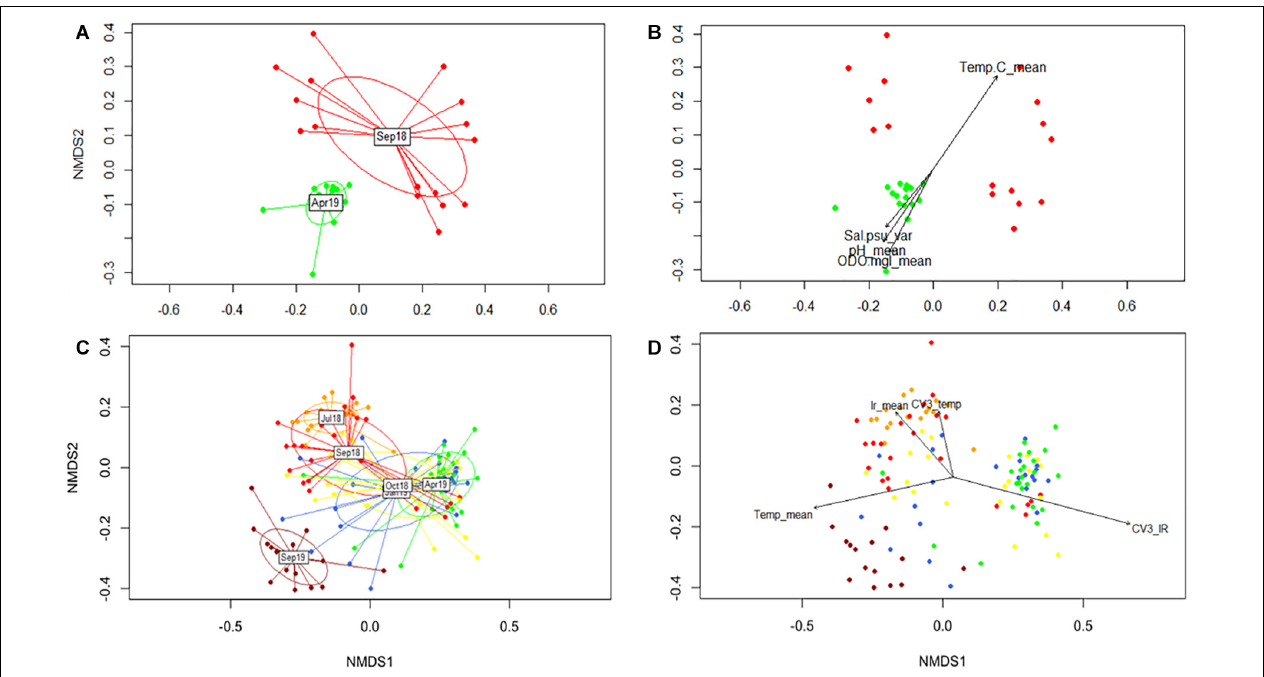
FIGURE 5 | Non-metric multidimensional scaling (NMDS) of global DNA methylation patterns using Gower distances. (A) Temporal separation for T5 and T12 for LP sites. (C) Representation of all sampling times for both shallow sites (LP and CR). (B,D) Significant correlations of environmental parameters to DNA methylation patterns ( P < 0.05). Colors correspond to collection